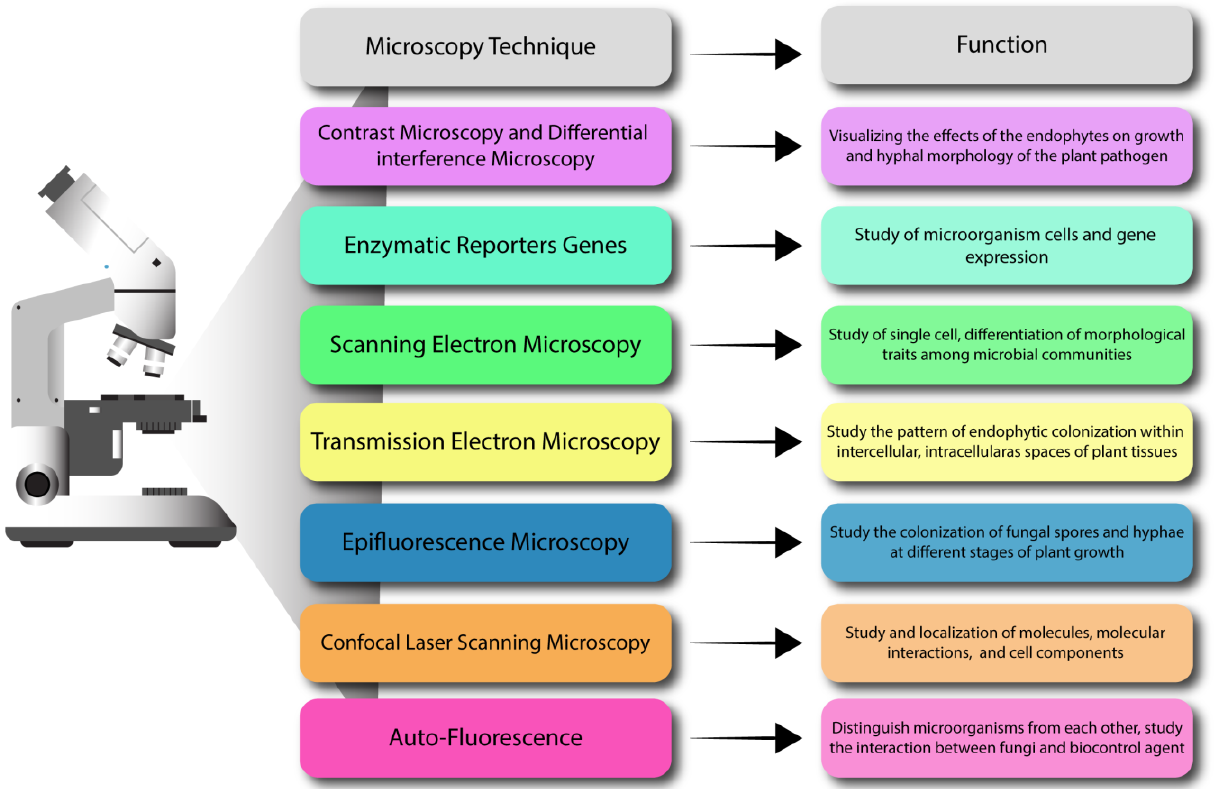
Figure 2. Microscopy techniques to study the interactions among plants, pathogens, and endophytes.